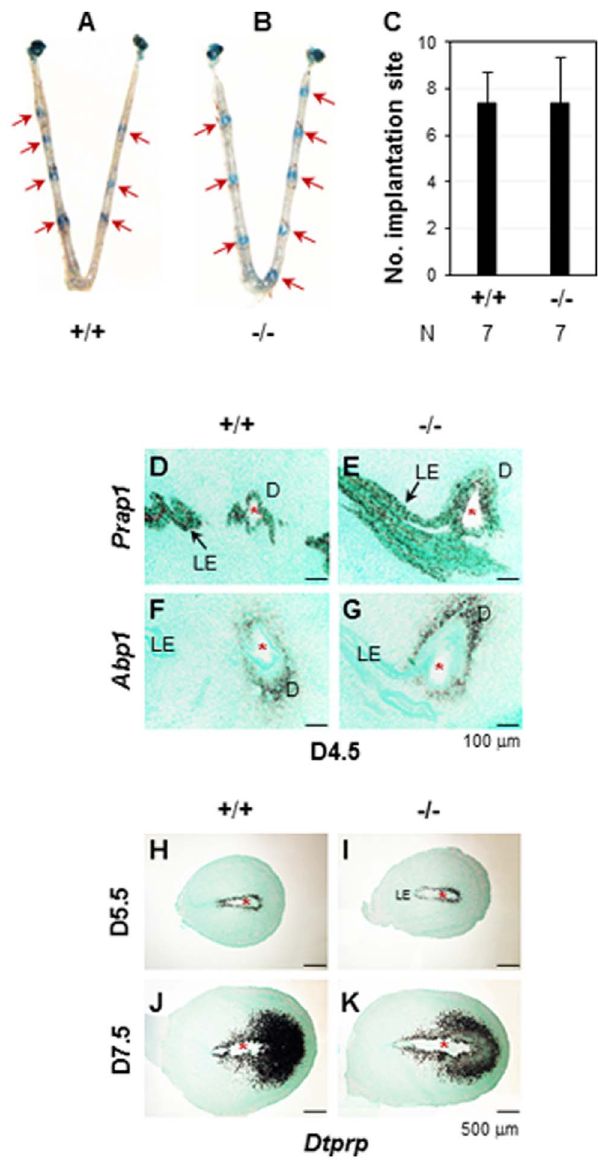
Figure 3. Deletion of Npl on embryo implantation and the expression of implantation and decidualization markers in gestation day 4.5 (D4.5), D5.5 and D7.5 uteri. + / + , wild type (WT); 2 / 2 , Npl ( 2 / 2 ) . A. A representative uterus from D4.5 WT mice. B. A representative uterus from D4.5 Npl ( 2 / 2 ) mice. Red arrow, implantation site. C. the number of implantation sites on D4.5. N, the number of female mice in each group; error bars, standard deviation. D–G. Expression of implantation markers in D4.5 uterus by in situ hybridization using Prap1 and Abp1 antisense probes, respectively. D. Prap1 in WT uterus. E. Prap1 in Npl ( 2 / 2 ) uterus. F. Abp1 in WT uterus.